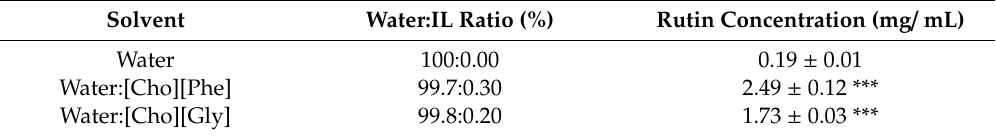
Table 1. Solubility of rutin in water or in water:IL mixtures (99.7:0.3%, w / w for [Cho][Phe]; and 99.8:0.2%, w / w for [Cho][Gly]); n = 3, mean ± SD and *** p < 0.001 (one-way ANOVA, Tukey’s test, compared to water solubility).